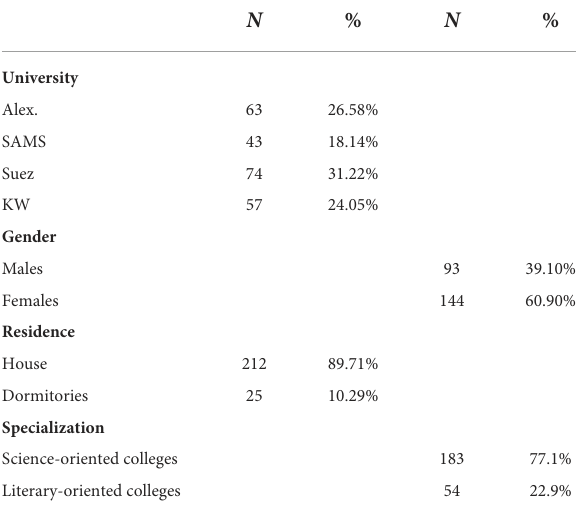
TABLE 1 Descriptive statistics of the study